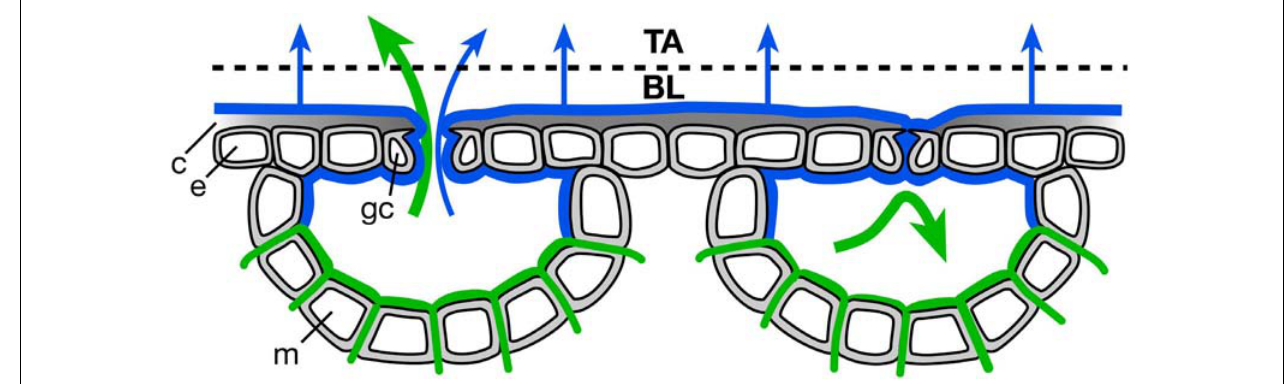
FIGURE 5 | The hypothesized role of thin liquid films in reducing microenvironmental variability across the leaf surface. Blue lines represent liquid formed by condensation to deposited hygroscopic aerosol on the leaf surface, including that which penetrates the stomatal pores; blue arrows represent the evaporative flux of water derived from this liquid. Green lines represent conventional apoplastic liquid water derived from the soil-root-xylem pathway passing through and around mesophyll cells (m); green arrows represent the much larger evaporative flux of this water when stomata are open (left side) and its elimination by stomatal closure (right side). Evaporation occurs from aerosol-condensed water with both open (left side) and closed (right side) stomata, as liquid continuity between leaf interior and exterior is maintained largely independently of stomatal pore area determined by guard cell (gc) turgor. The leaf boundary layer (BL) is uniformly humidified across the leaf surface and the osmotic environment of the cuticle (c) and underlying epidermis (e) is made more homogeneous by the presence of a liquid film. All fluxes (blue and green arrows) eventually pass through the BL and enter the mixed free atmosphere (TA), representing water loss from the leaf.